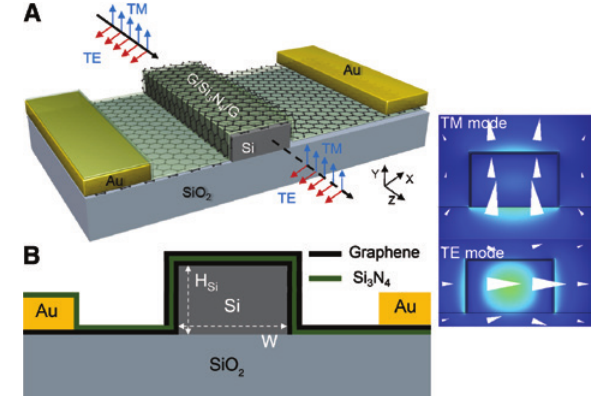
Figure 2: The structure of the polarization-insensitive optical modulator. (A) Three-dimensional schematic illustration of the device and (B) cross-section of the hybrid Si waveguide. Inset: electric field distribution of TM and TE